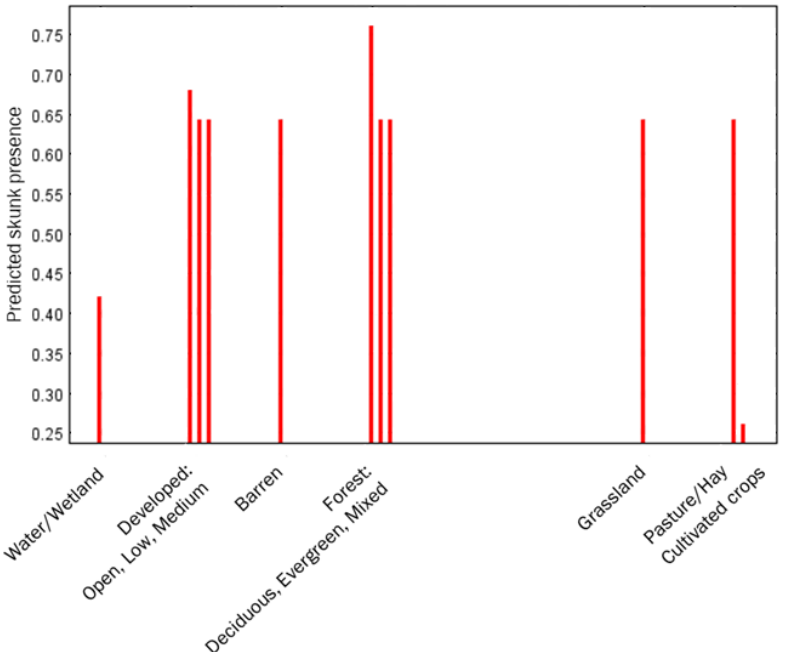
Figure 4. Predicted striped skunk presence as a function of land cover class as described by the NLCD [15] based on striped skunk occurrences collected during January to April 2008–2010 and